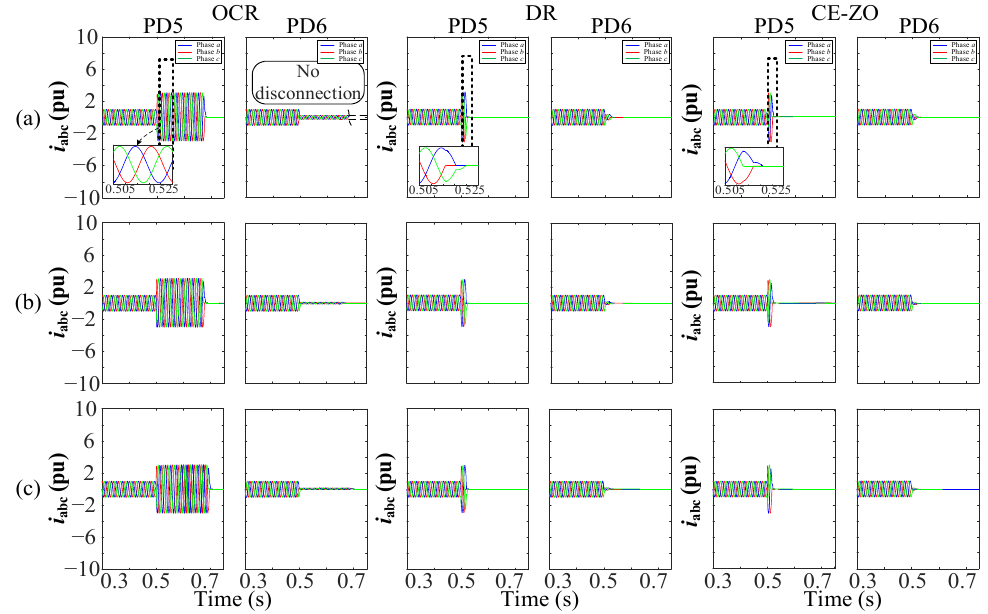
Figure 5. Short-circuit current for OCR, DR, and CE-ZO behavior during a three-phase fault in DL3 with fault resistance r = 0.1 Ω ( a ) with two DGs, ( b ) with one DG, and ( c ) without DG. Table 2. OCR settings.